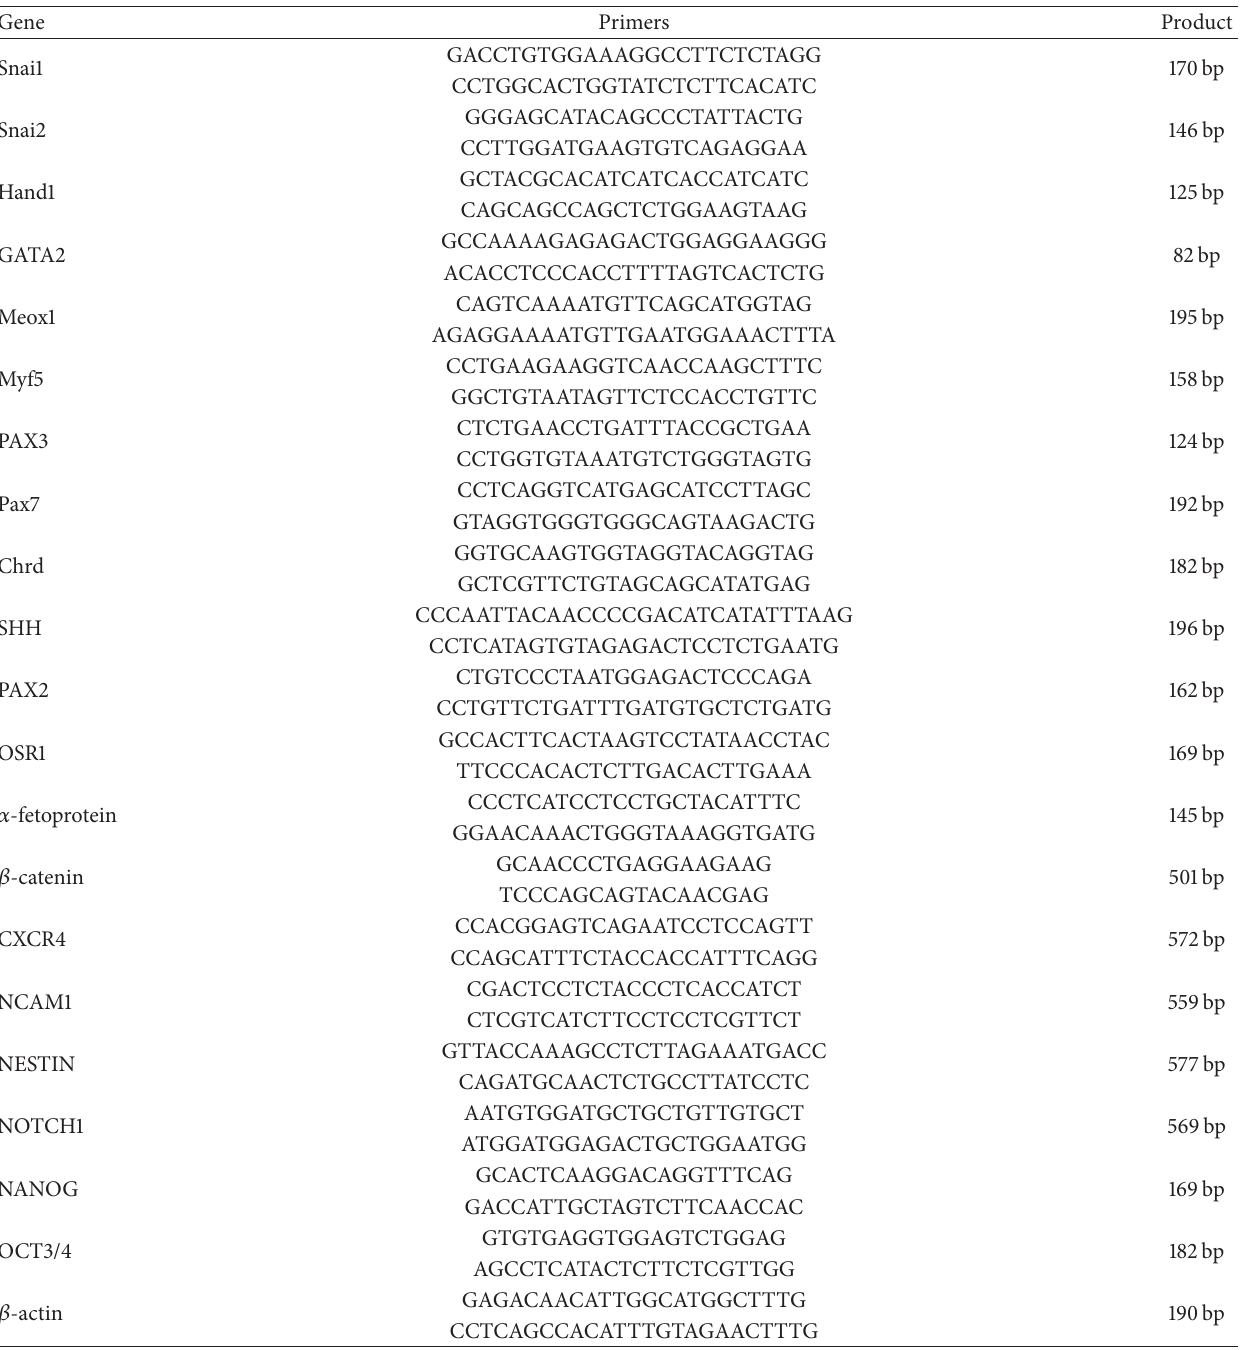
Table 1: The primers sequence for